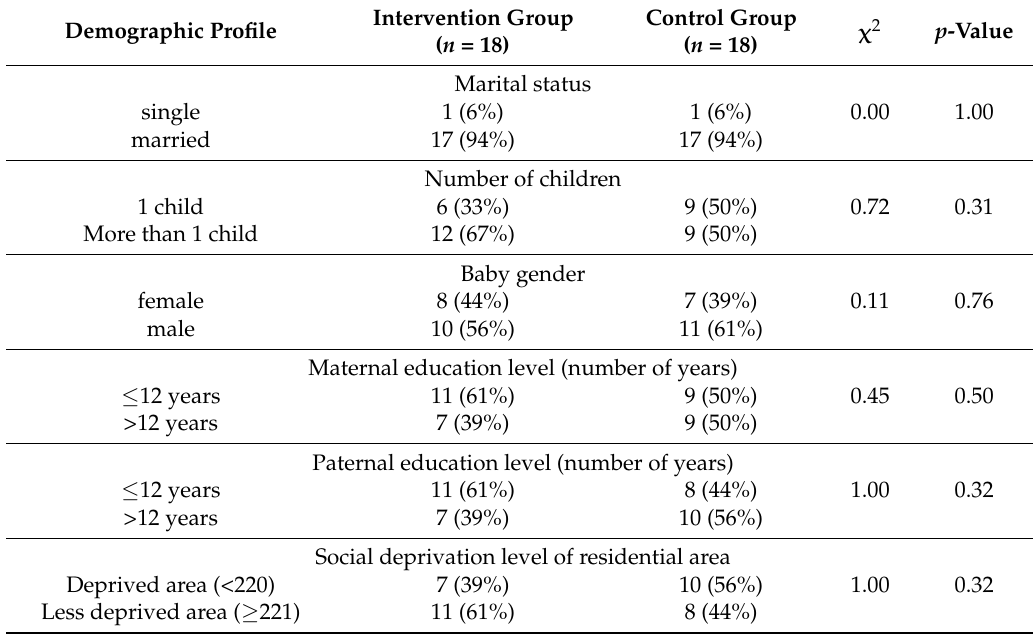
Table 2. Demographic profiles of Chinese migrant